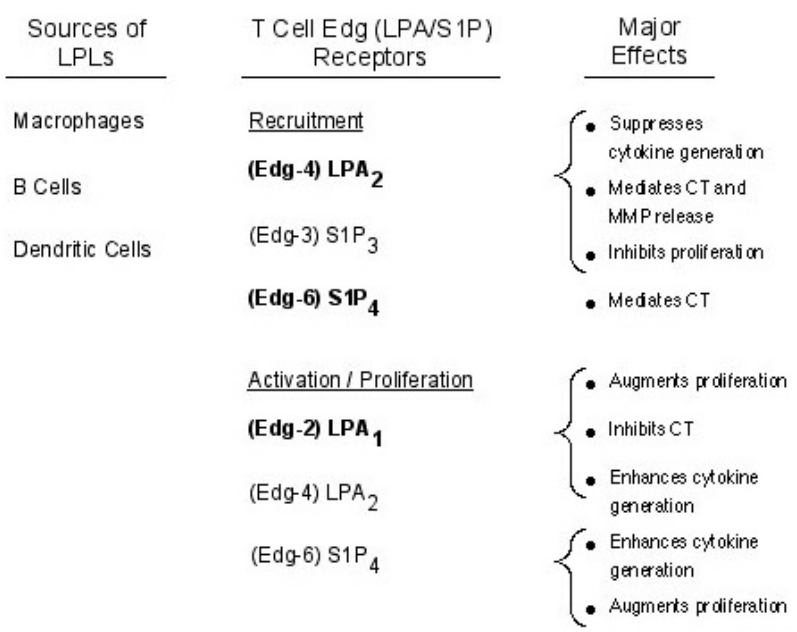
FIGURE 2. LPLs in human T cell(cid:150)dependent immune responses. CT = chemotaxis, MMP = matrix